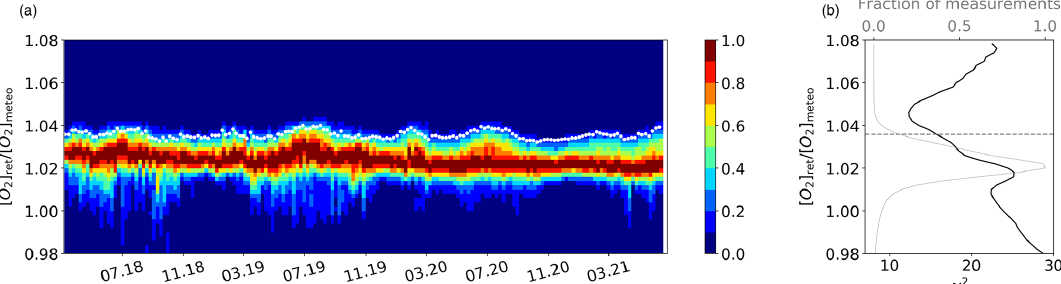
Figure 7. (a) Time series of weekly distribution of the ratio of retrieved non-scattering O 2 to meteorological (ECMWF) O 2 . The ratio distribution is normalized such that the maximum occurrence corresponds to the red value 1. White dots are the upper-edge ensemble defined as the scenes between the 95th and 99th percentile of the distribution. (b) Distribution of the [ O 2 ] / [ O 2 , met ] ratio as a function of the fitting quality χ 2 (black line) and the fraction of measurements for each ratio bin (grey line). The horizontal dashed line corresponds to the upper- edge factor computed as the average over the 3-year period shown in panel (a)